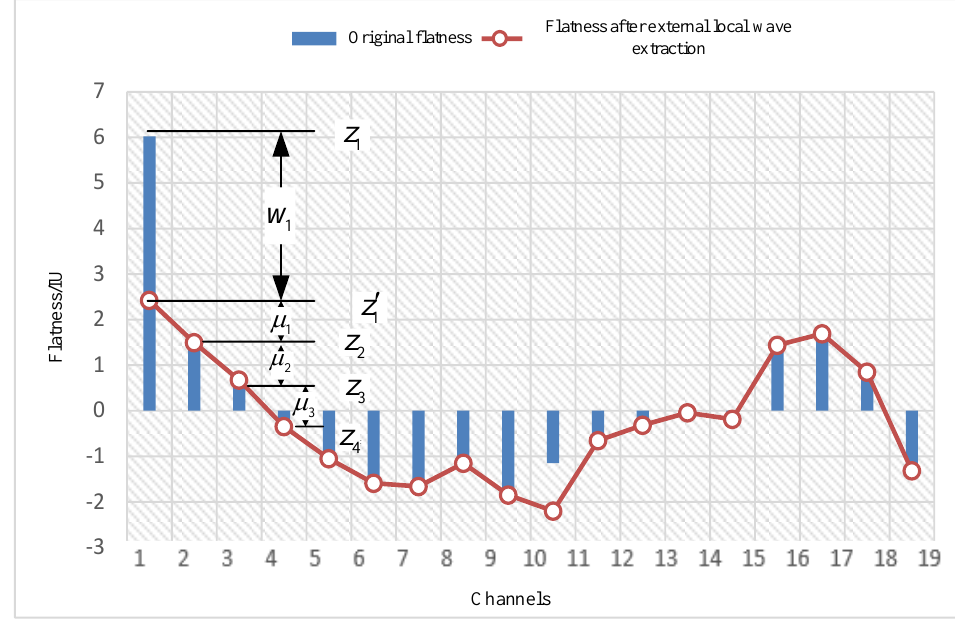
Figure 5. Principle of the external local wave shape defect recognition and extraction.